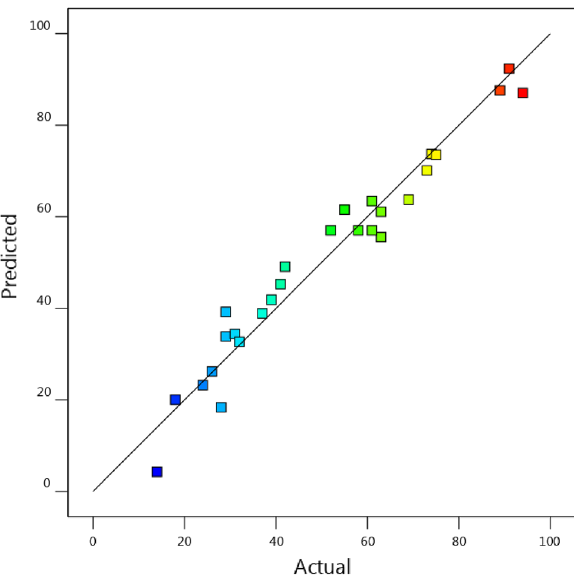
Figure 5. Predicted values of RE vs. actual values obtained by Design